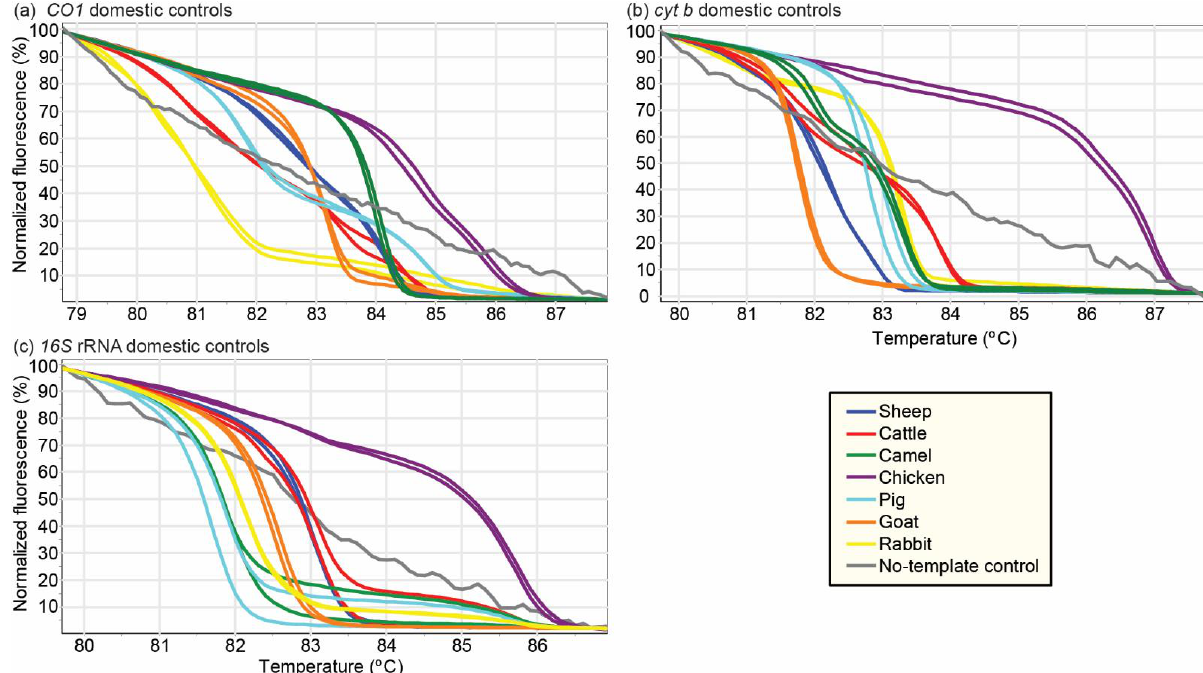
Figure 1. Distinct normalized PCR-HRM profiles of meat from seven reference livestock species. HRM profiles are represented as percent fluorescence with increasing temperatures for ( a ) CO1 , ( b ) cyt b , and ( c ) 16S rRNA markers. All unknown samples were compared against these reference profiles for identification of vertebrate species.